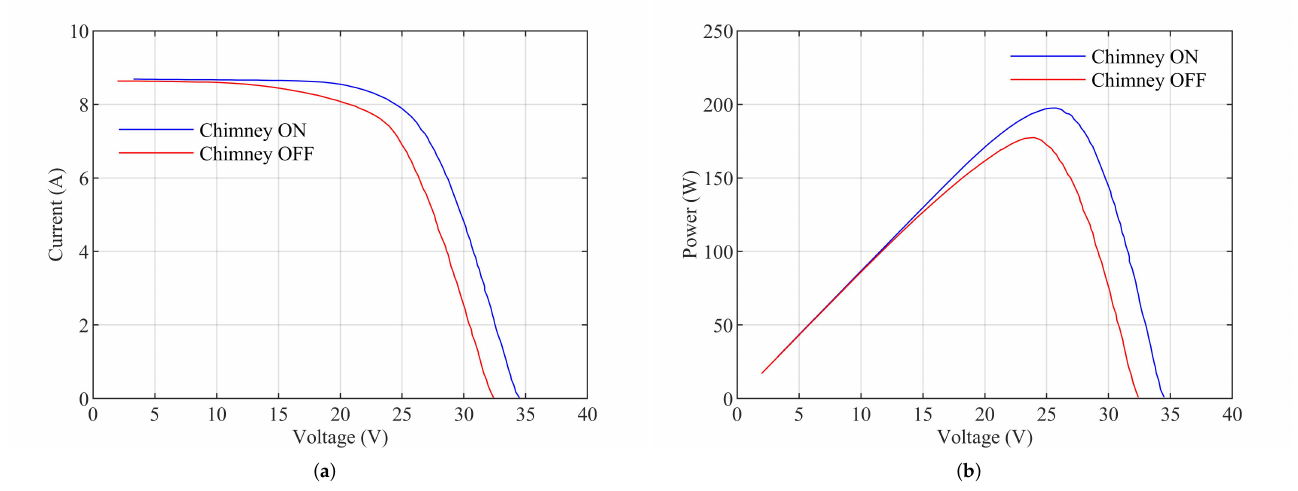
Figure 11. ( a ) I–V curves comparison with chimney activated and deactivated. ( b ) P–V curves comparison with chimney activated and